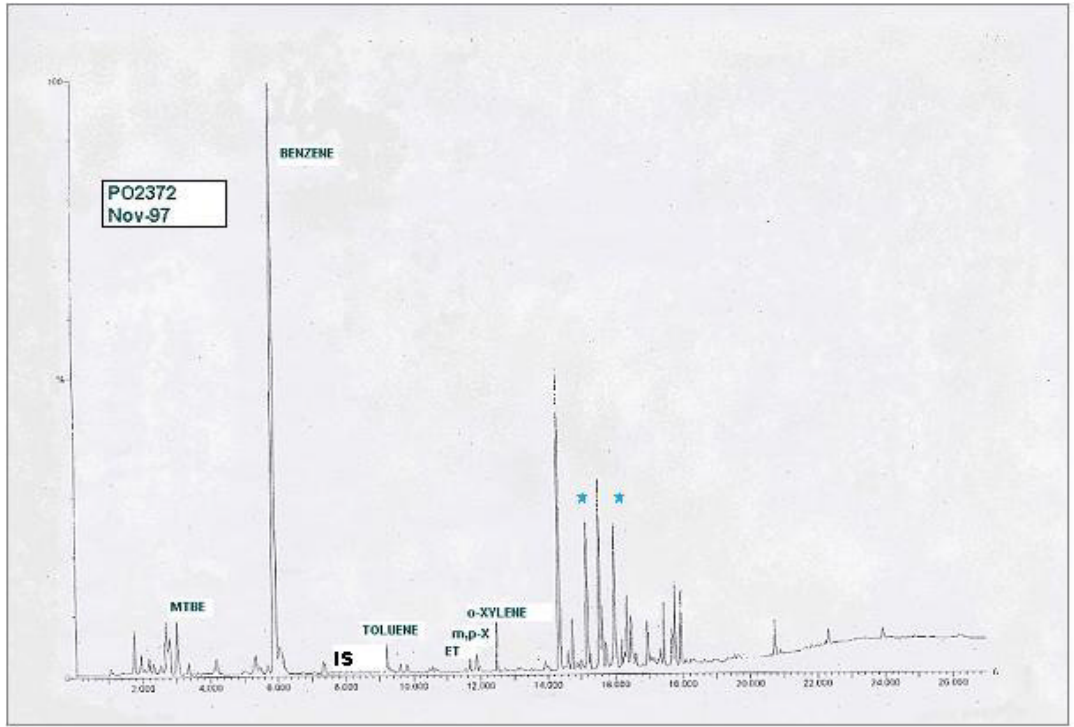
FIGURE 2. Chromatogram of well PO2372 taken in November 1997. Peaks assigned to DCPDs compounds are star marked. (IS = Internal standard).